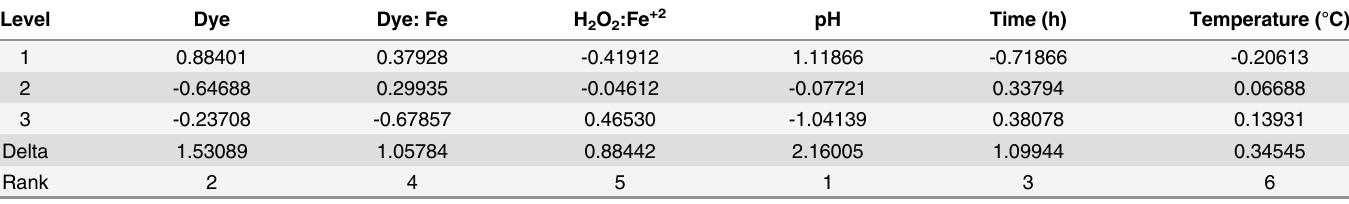
Table 10. List of TPCI